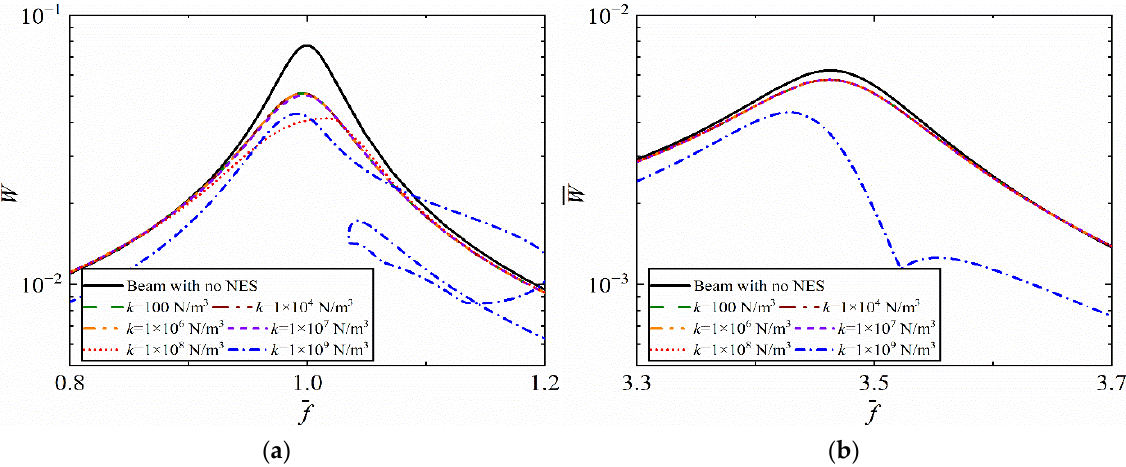
Figure 7. ( a ) Response at the first resonance frequency; ( b ) response at the second resonance fre- quency.